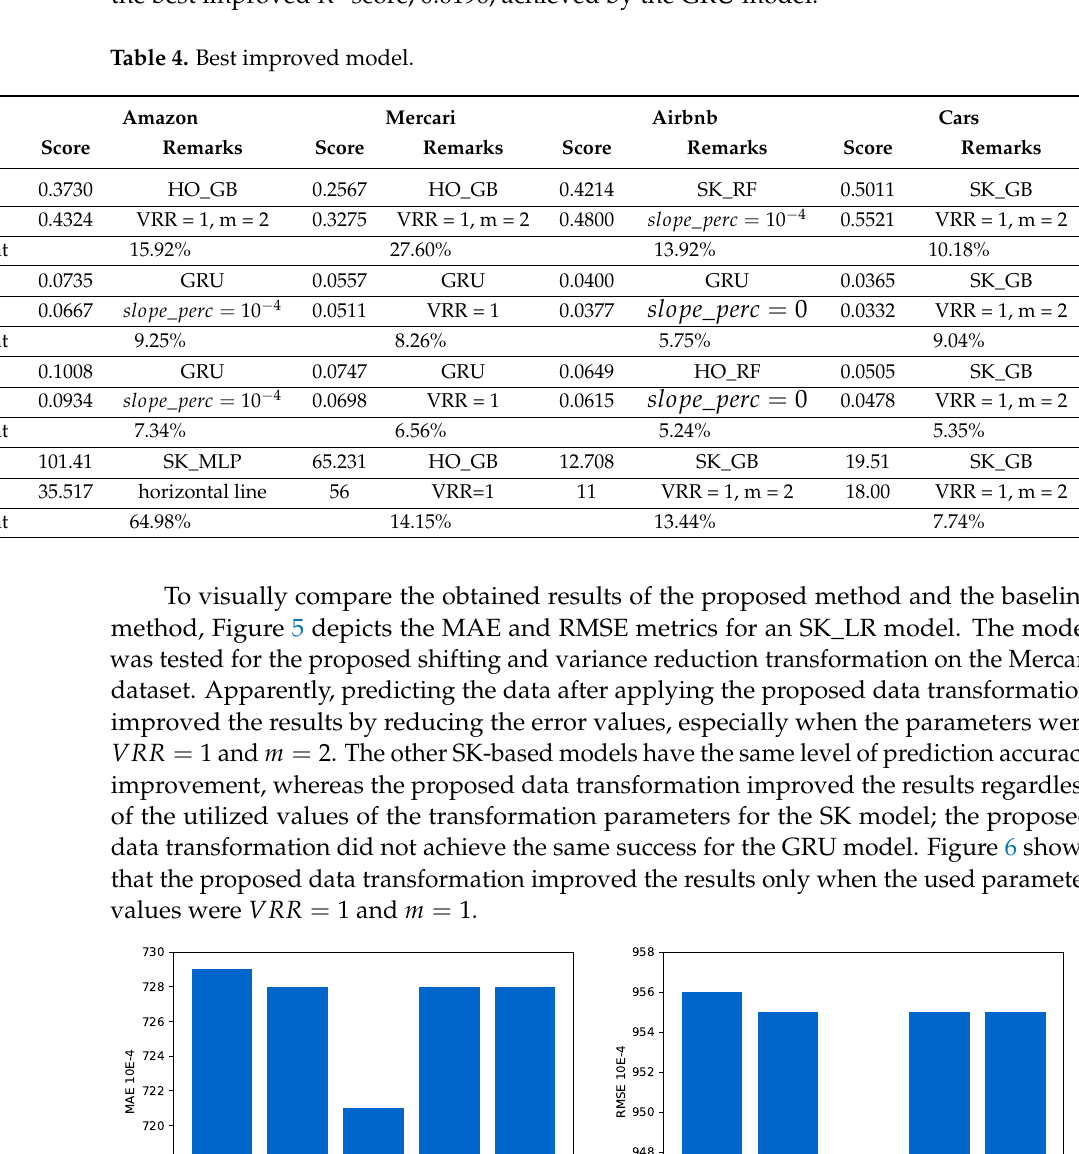
( b ) RMSE error metric.